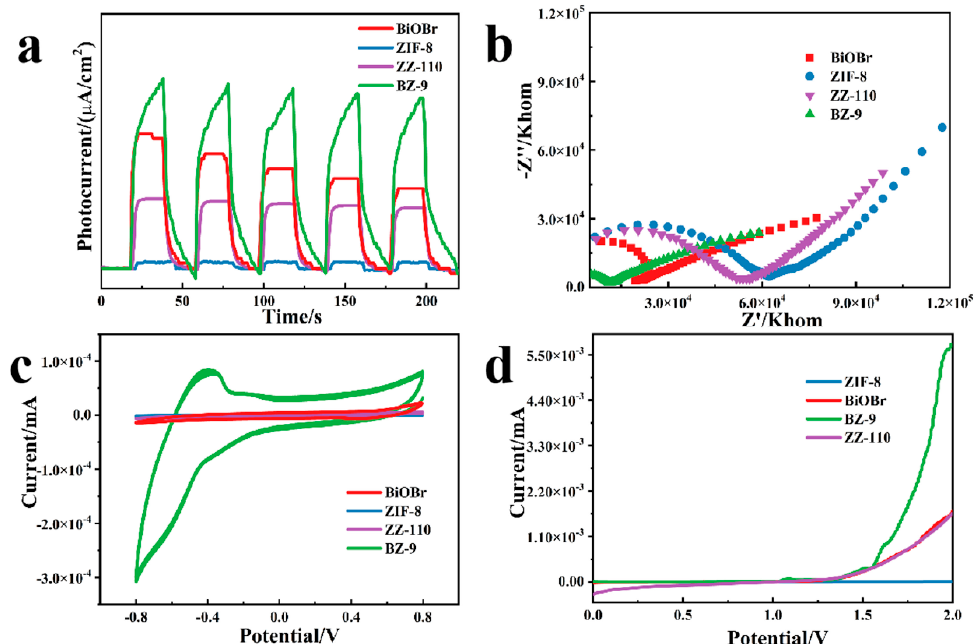
Figure 4. Photocurrent response ( a ); Nyquist plots of the electrochemical impedance spectra ( b ); Cyclic voltammetry curve ( c ); Linear sweep voltammetry curve of BiOBr, ZIF − 8, ZZ − 110, and BZ − 9 photocatalysts ( d ).